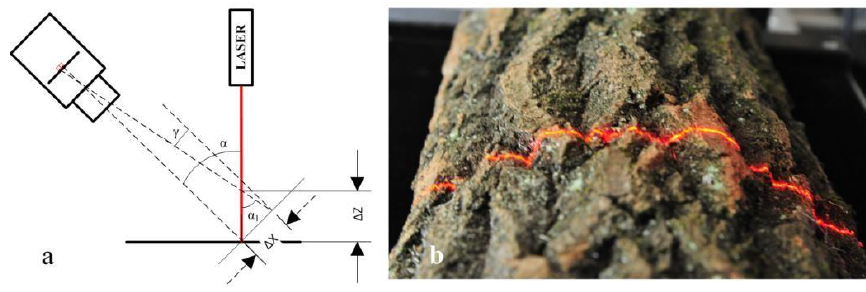
Figure 3. Bark surface imaging. ( a ) A configuration of the video system. ( b ) An image of the laser beam projected onto the surface of the examined bark samples.